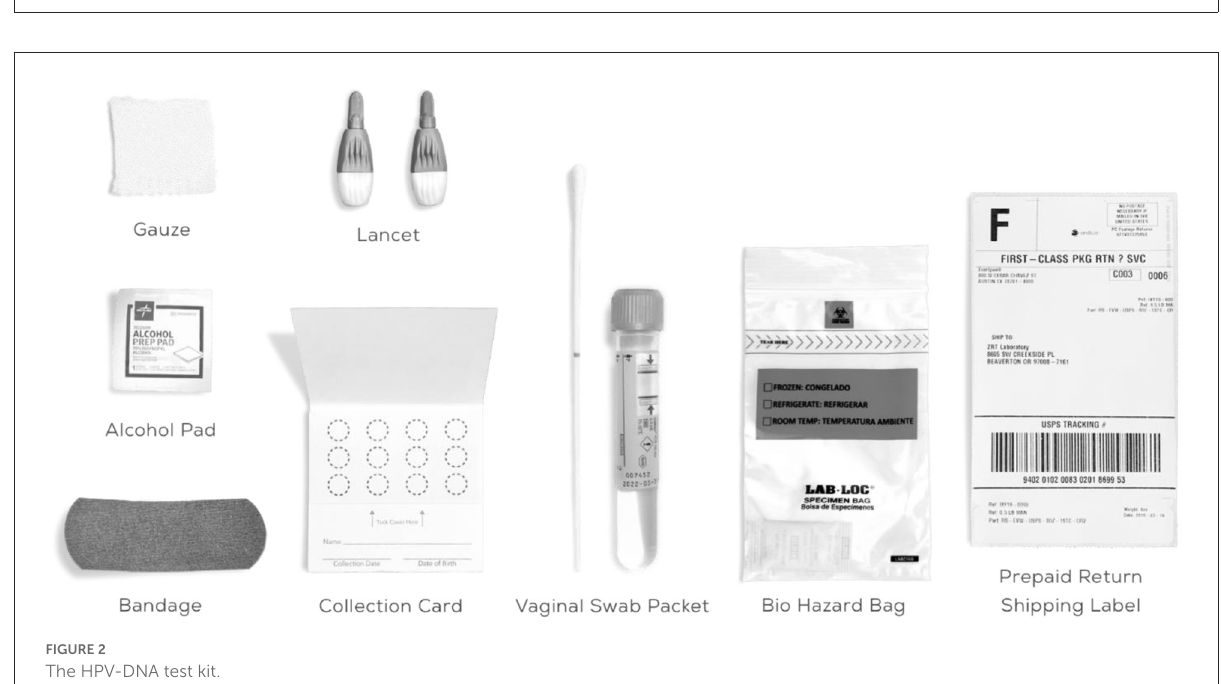
FIGURE2 The HPV-DNA test